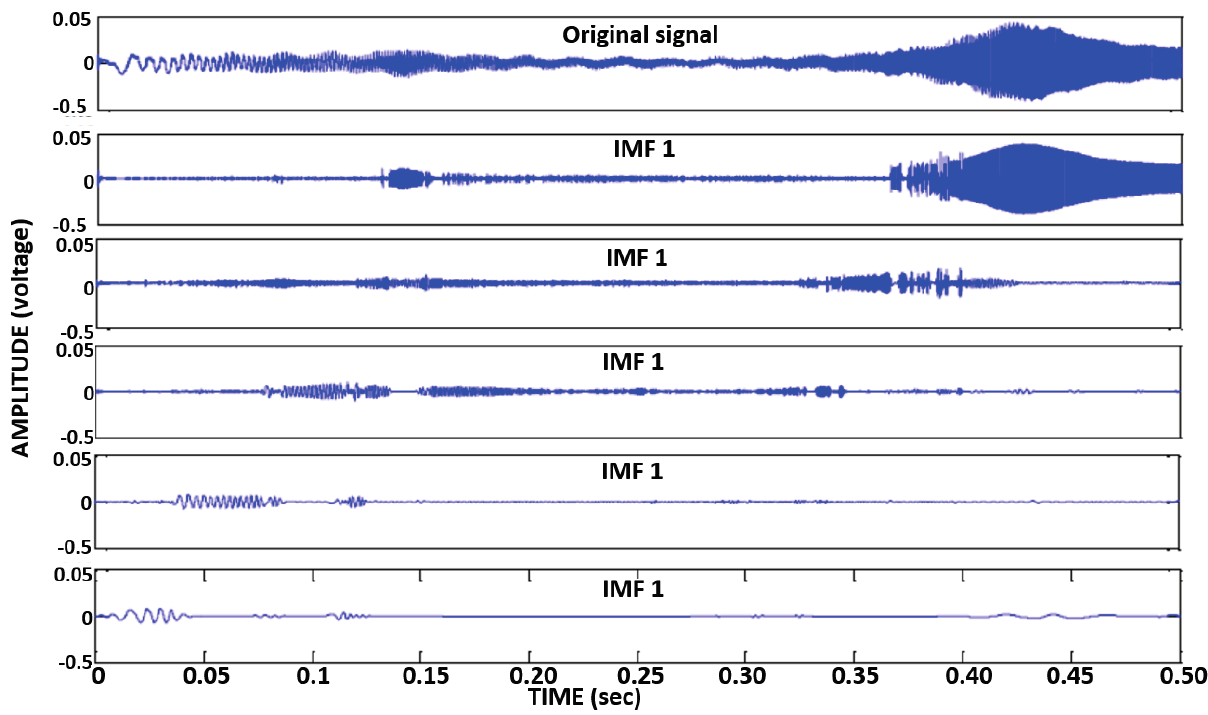
Figure 8. A typical sensor’s vibration response to the chirp (original signal) and its first five IMFs obtained through